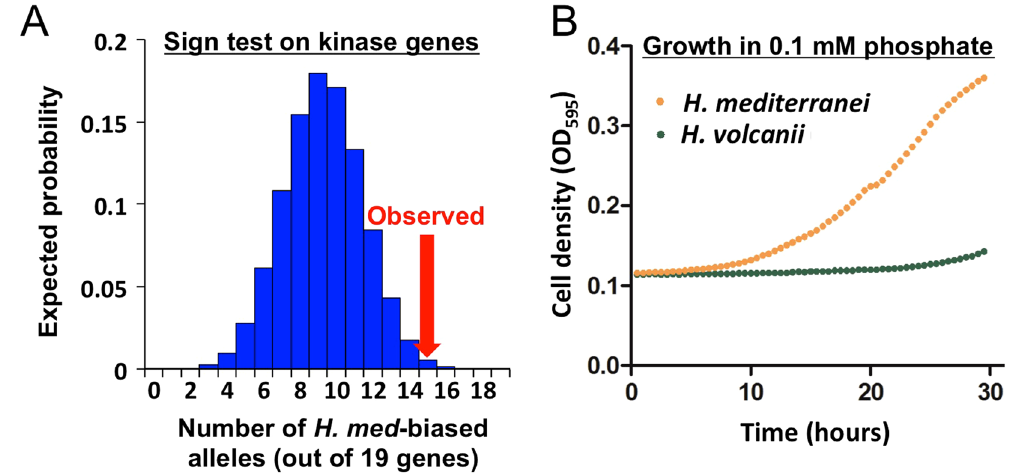
Figure 3. Detection of lineage-specific selection and differential fitness in low phosphate conditions. ( A ) For a set of 19 genes, the expected number with ASE with higher expression from the H . mediterranei alleles is plotted. The kinase gene set had 15/19 genes favoring the H . mediterranei alleles (red arrow), in both biological replicates. ( B ) H . mediterranei grows robustly in 0.1 mM phosphate, whereas H . volcanii does not. See also Supplementary Fig.